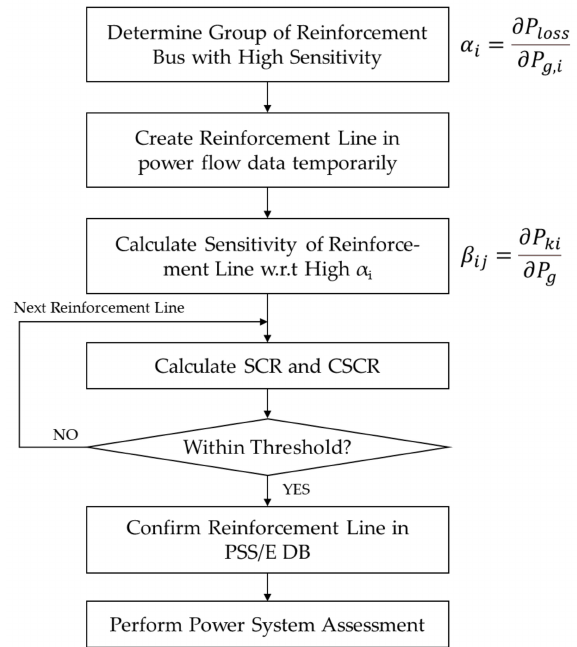
Figure 6. The process to find the optimal placement of the reinforcement